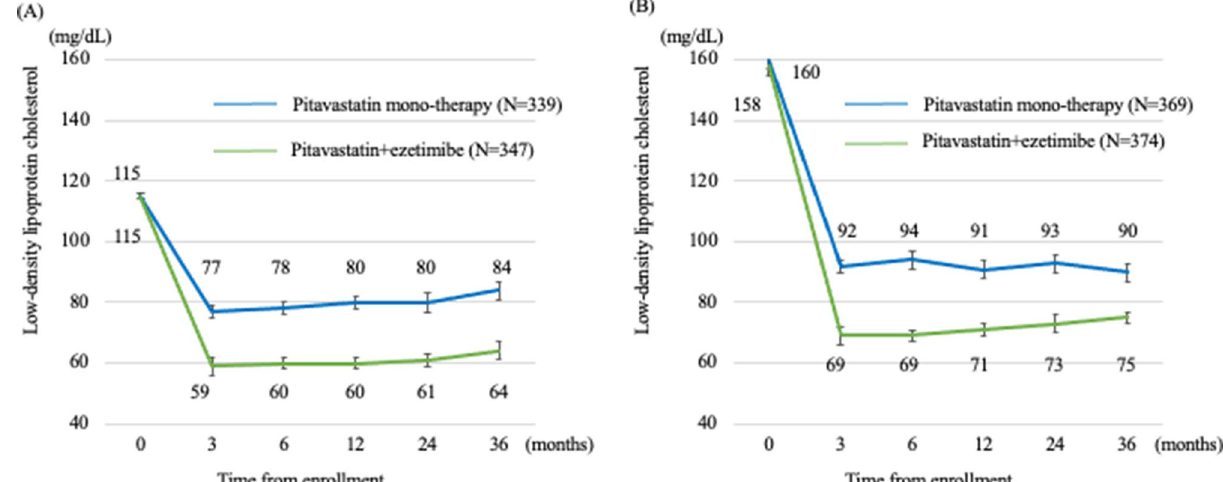
Figure 2. Changes in the mean LDL-C levels in the LDL-C < 131 mg/dL group ( A ) and the LDL-C < 131 mg/ dL group ( B ). LDL-C, low-density lipoprotein cholesterol. LDL-C levels are expressed as mean ± 95% confidence